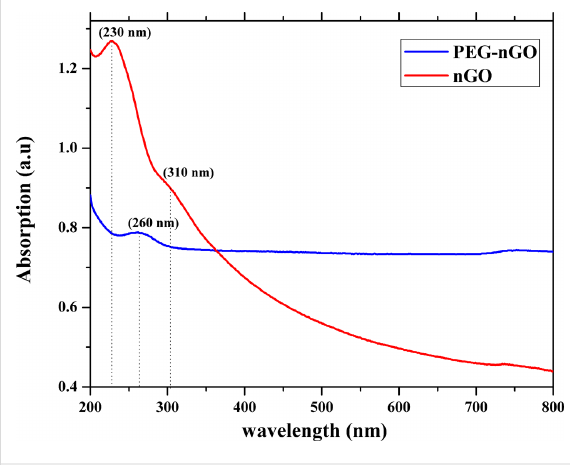
Figure 2: FTIR spectra of nGO and PEG-nGO. Additional peaks in the fingerprint region demonstrate the successful PEGylation of nGO.